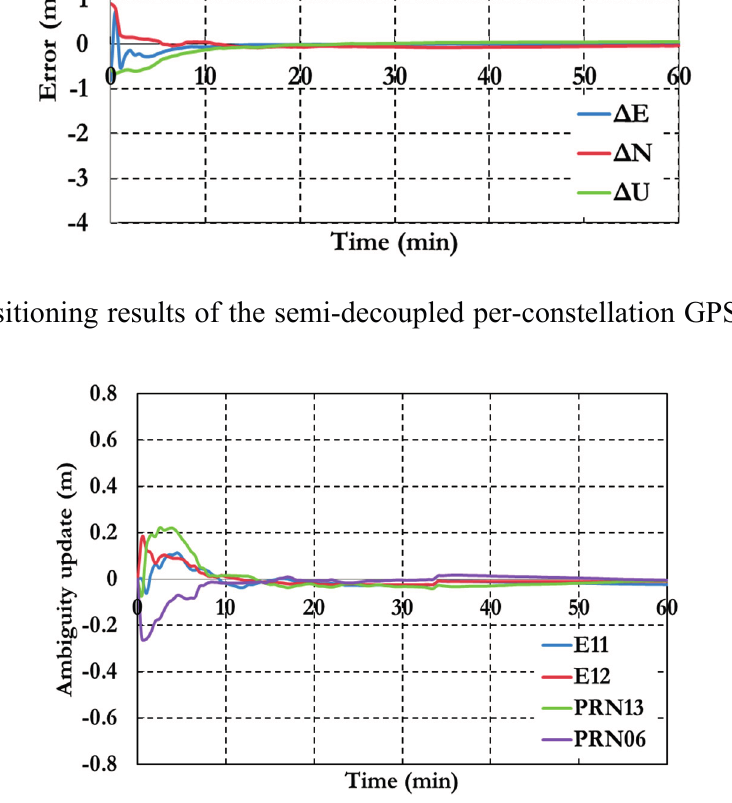
Figure 23. Ambiguity parameters the semi-decoupled per-constellation GPS/Galileo BSSD PPP